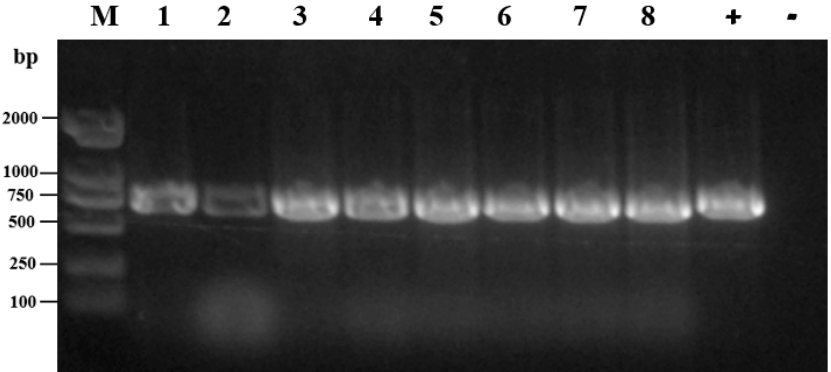
Figure 3. PCR assays for the detection of Salmonella spp. isolates. M: molecular weight standards of DL 2000; Lanes 1–8: Eight Salmonella strains; +: positive control ( S. pullorum CVCC 526); − : Negative control ( S. enteritidis CVCC 3377).